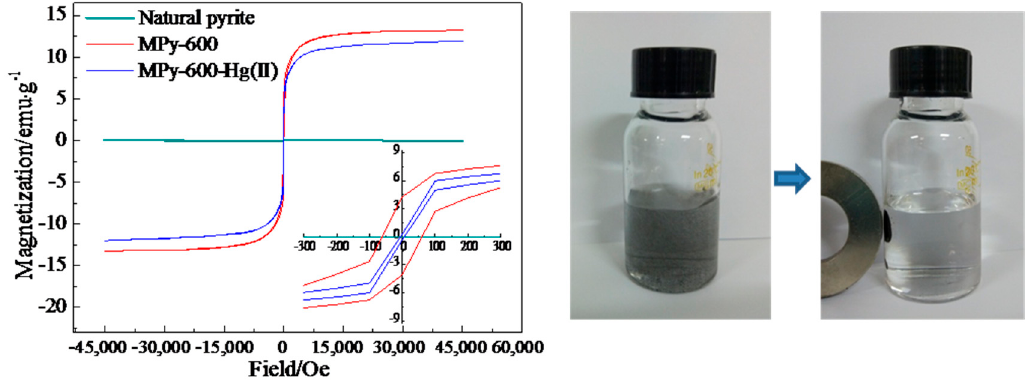
Figure 6. Magnetization characteristics of natural pyrite, MPy600, and MPy-600 after